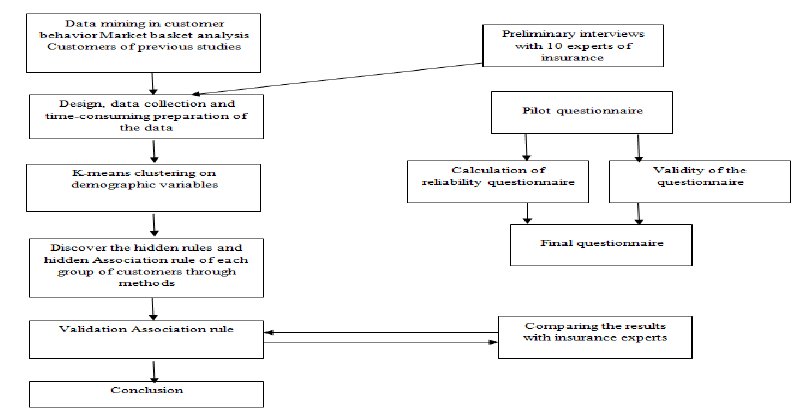
Fig. 1. The structure of the proposed